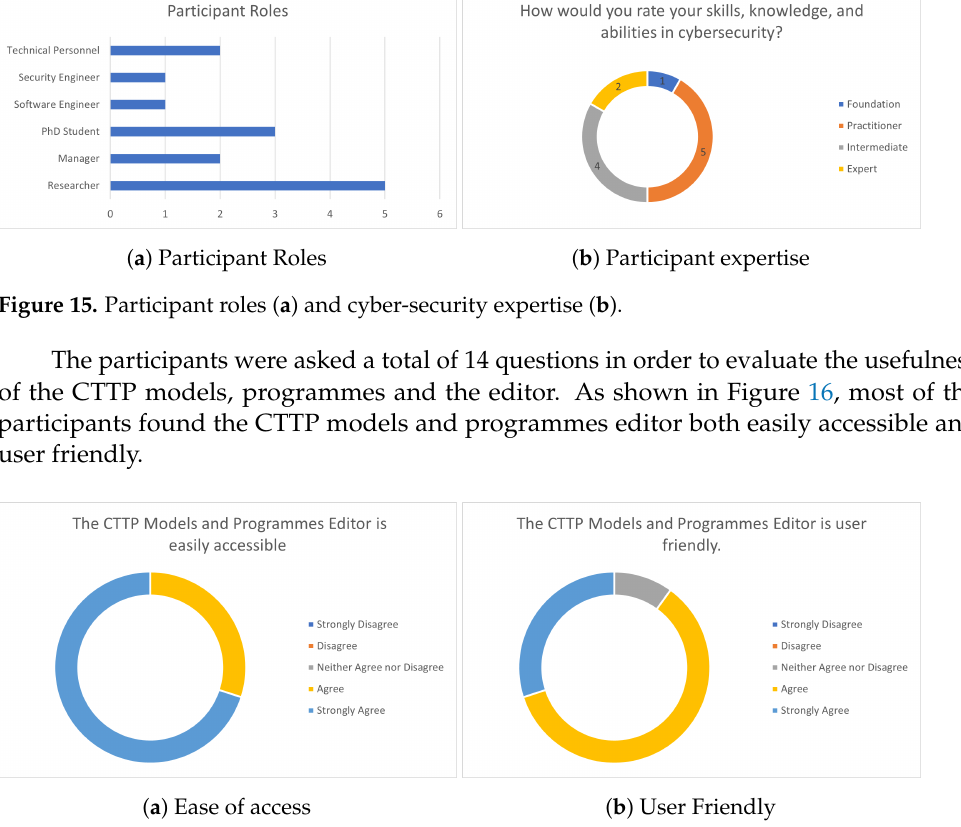
Figure 16. CTTP models and programmes editor’s usage. ( a ) and ( b ) presents the participants response regarding the Editors’ Ease of access and user-friendliness